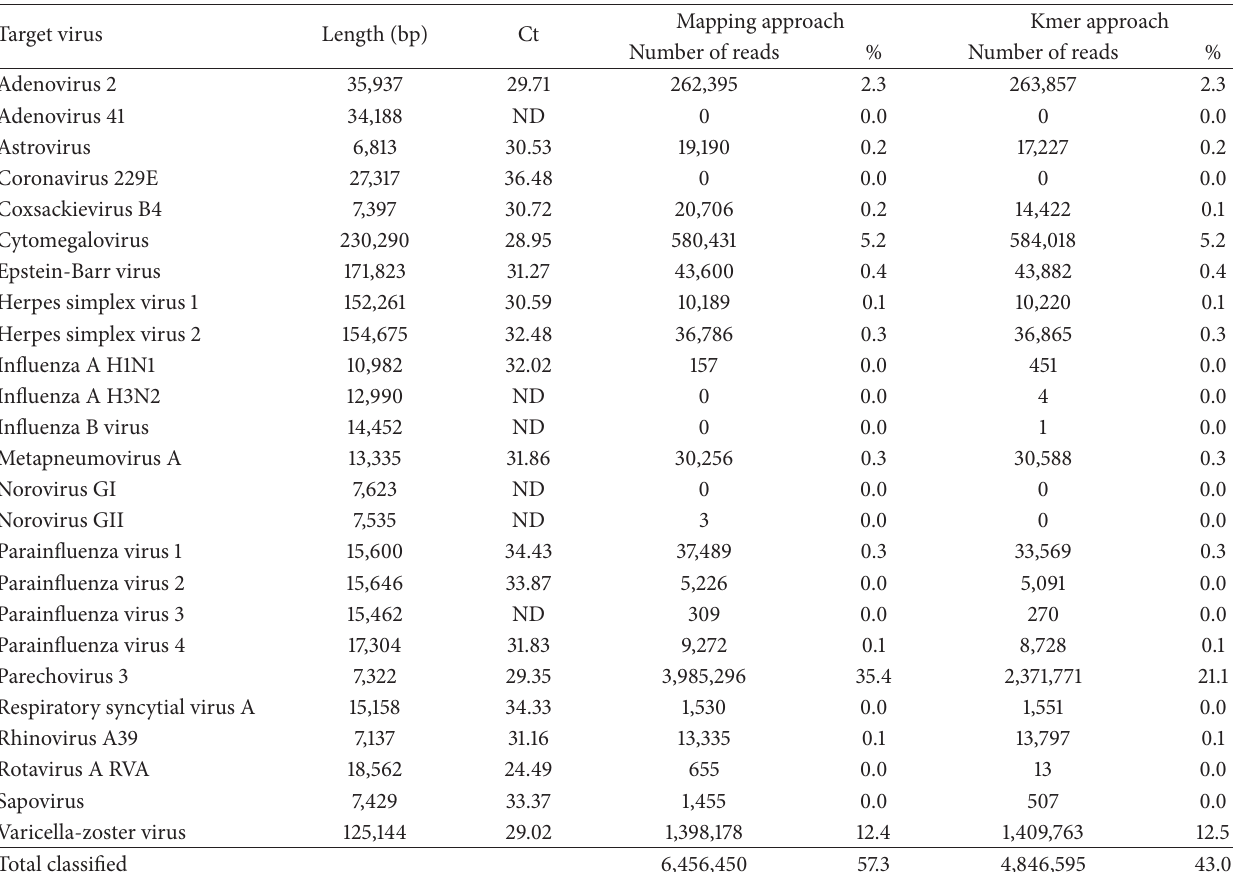
Table 1: Identification of the 25 target viruses within the viral sample using the two taxonomic classification approaches. Genome lengths based on reference genome used within the study and relative viral load shown by qPCR cycle threshold (Ct). If Ct > 37 this is shown as ND (not detectable). Percentages are based on the total reads within each dataset after preprocessing